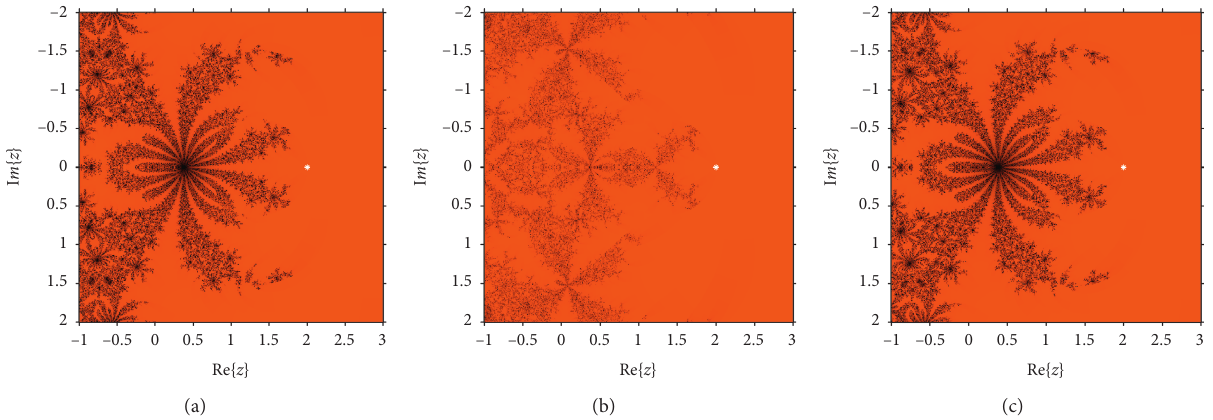
Figure 4: Basins of attraction of (a) SFM1, (b) SFM2, and (c) SFM3 for g